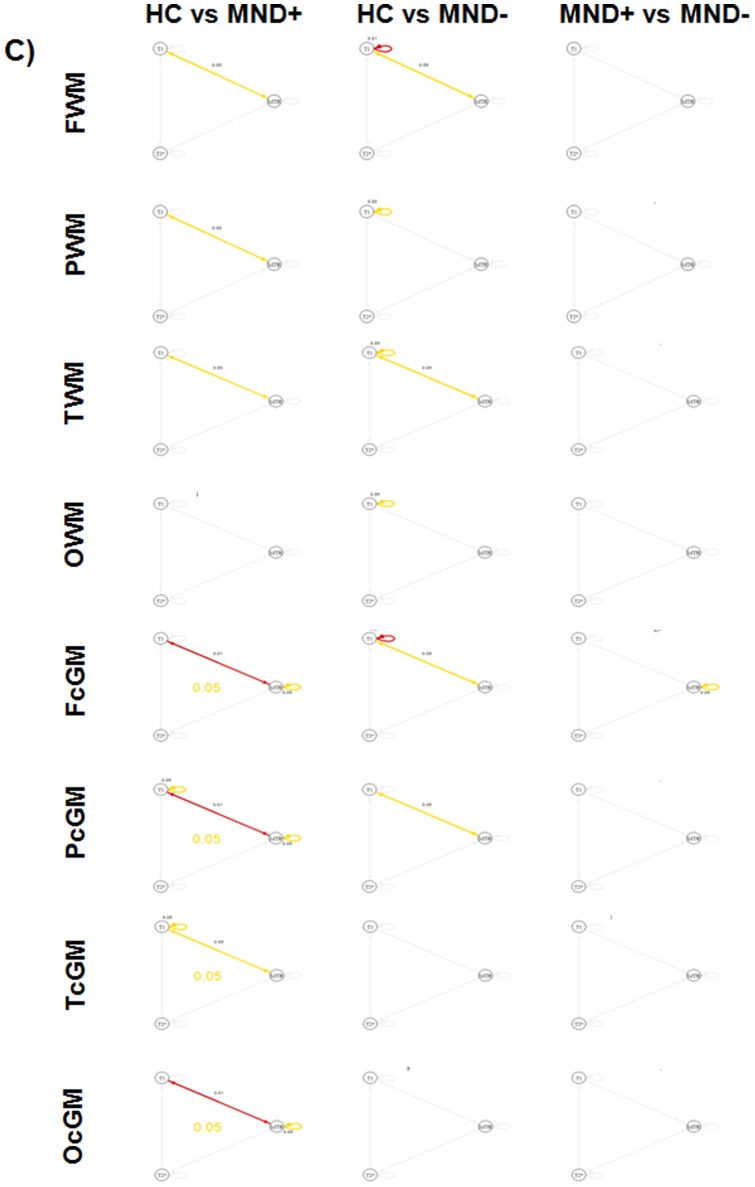
Graphs showing the respective significance in each ROI for univariate analysis (loop), bivariate analysis (straight line) and multivariate analysis (central circle).Red color indicates p≤0.01 and yellow color indicates p≤0.05. Hypothesis 3.